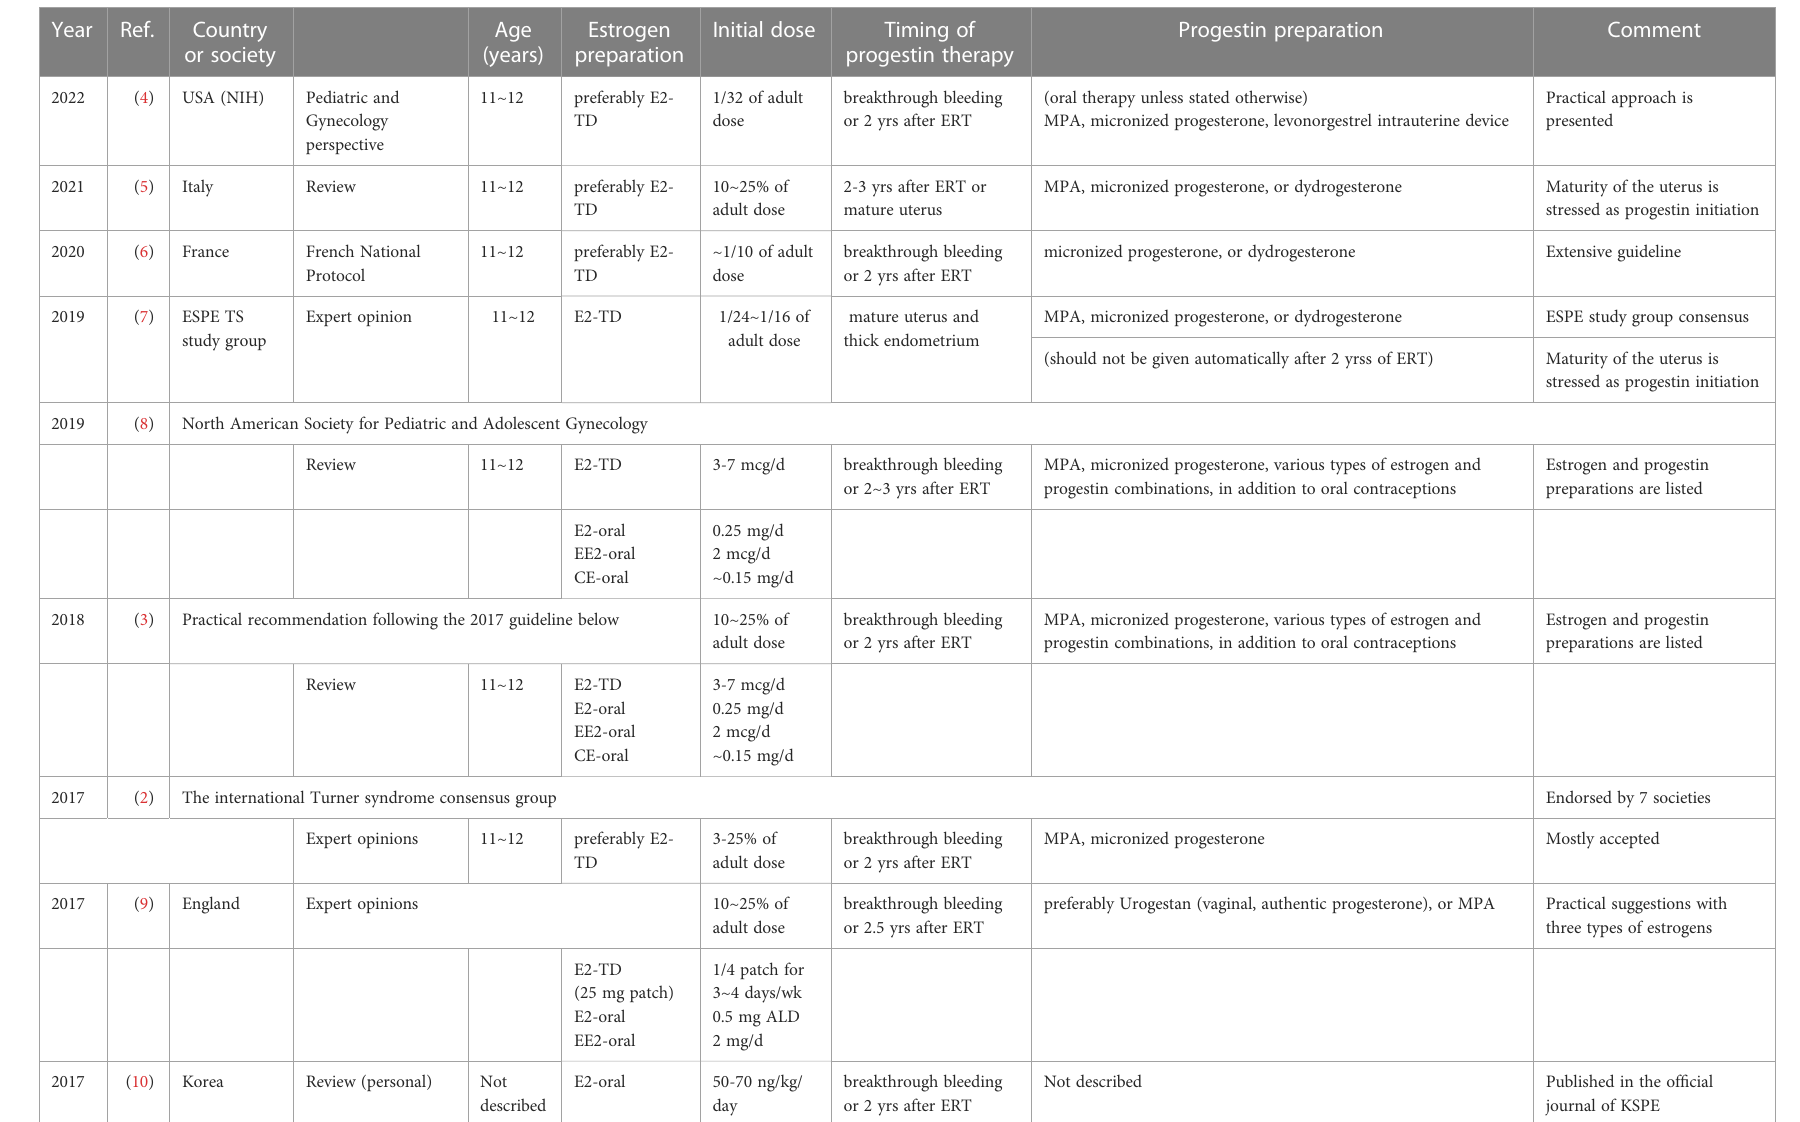
TABLE 1 Guideline publications on pubertal induction in Turner